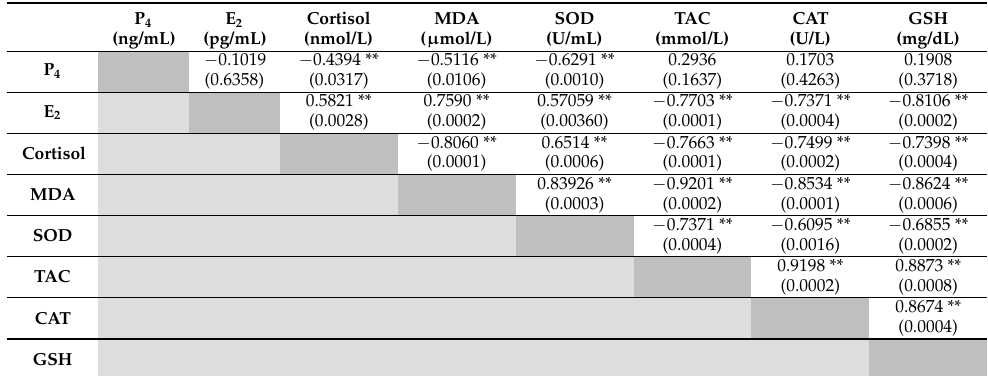
Table 7. Pearson correlation coefficient between steroids hormones, MDA, SOD, TAC, CAT and GSH in non-pregnant non-lactating ( n = 14), non-pregnant lactating ( n = 8) and pregnant ( n = 38) she-camels.